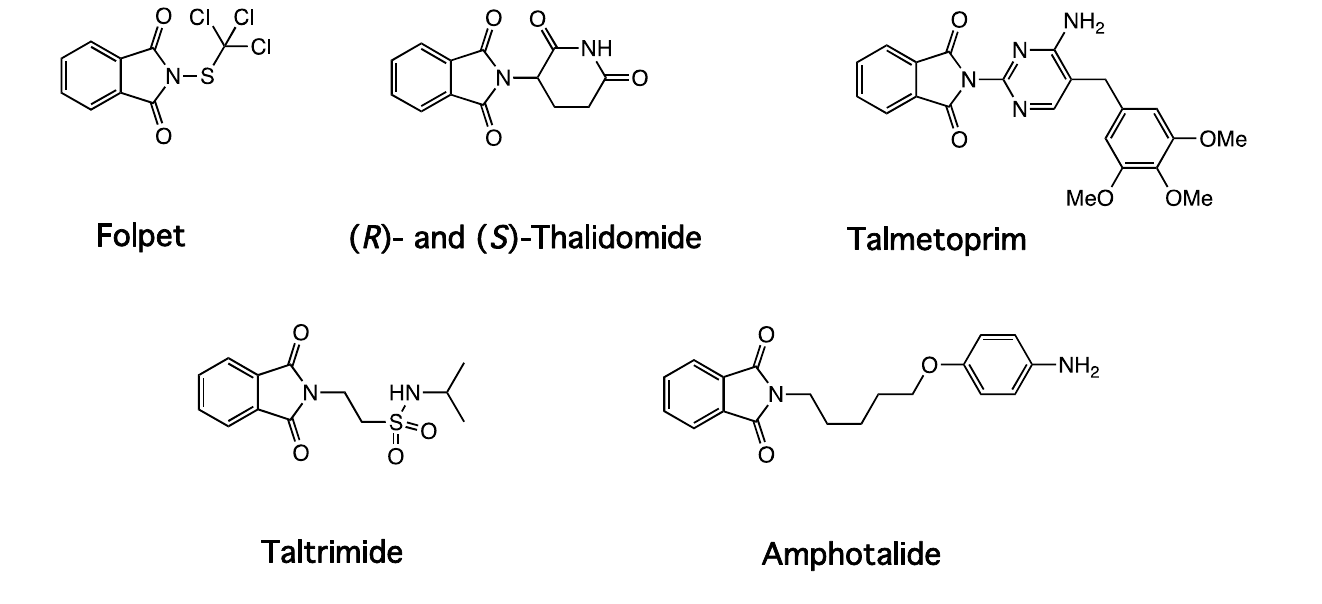
Figure 1. Phthalimide-containing drugs.